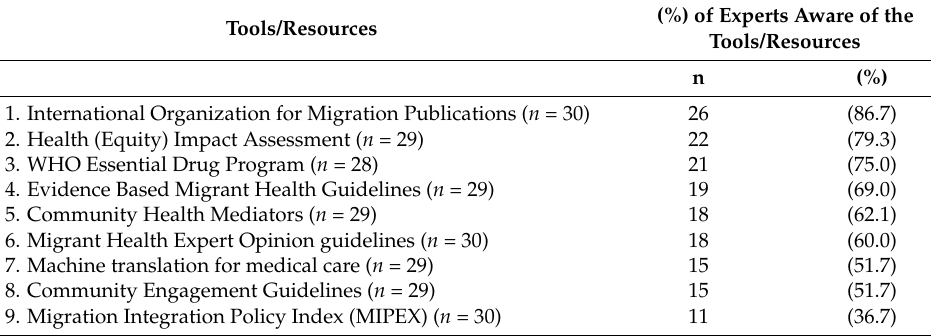
Table A3. Percentage of Experts Aware of Practice Based Resources and Migration.